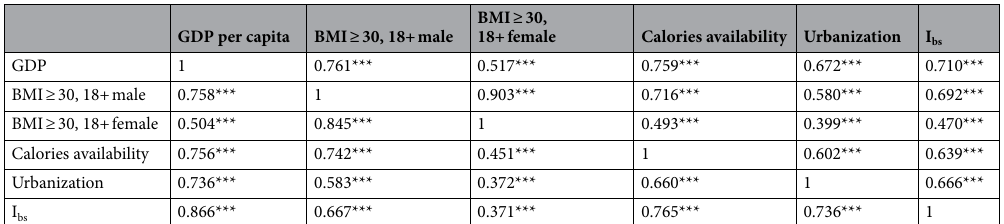
Table 1. Pearson r correlation (above the diagonal) and Spearman rho (below the diagonal) between all variables. Pearson (two-tailed) is reported. Number of countries included in the analysis range from 172 to 191. Data sources: Total calories availability data from the FAO’s FAOSTAT. BMI ≥ 30 prevalence (male and female) from the WHO Global Health Observatory; GDP per capita from the World Bank; Urbanization data from WHO; I bs from the previous publications. ***All correlations are significant at the 0.001 level (two-tailed).